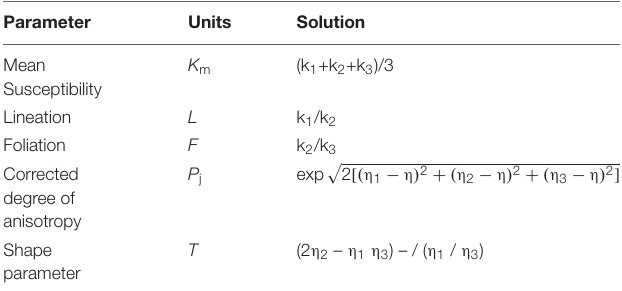
TABLE 1 | Anisotropy parameters used by Anisoft software and can be found in Jelinek (1981). Parameter